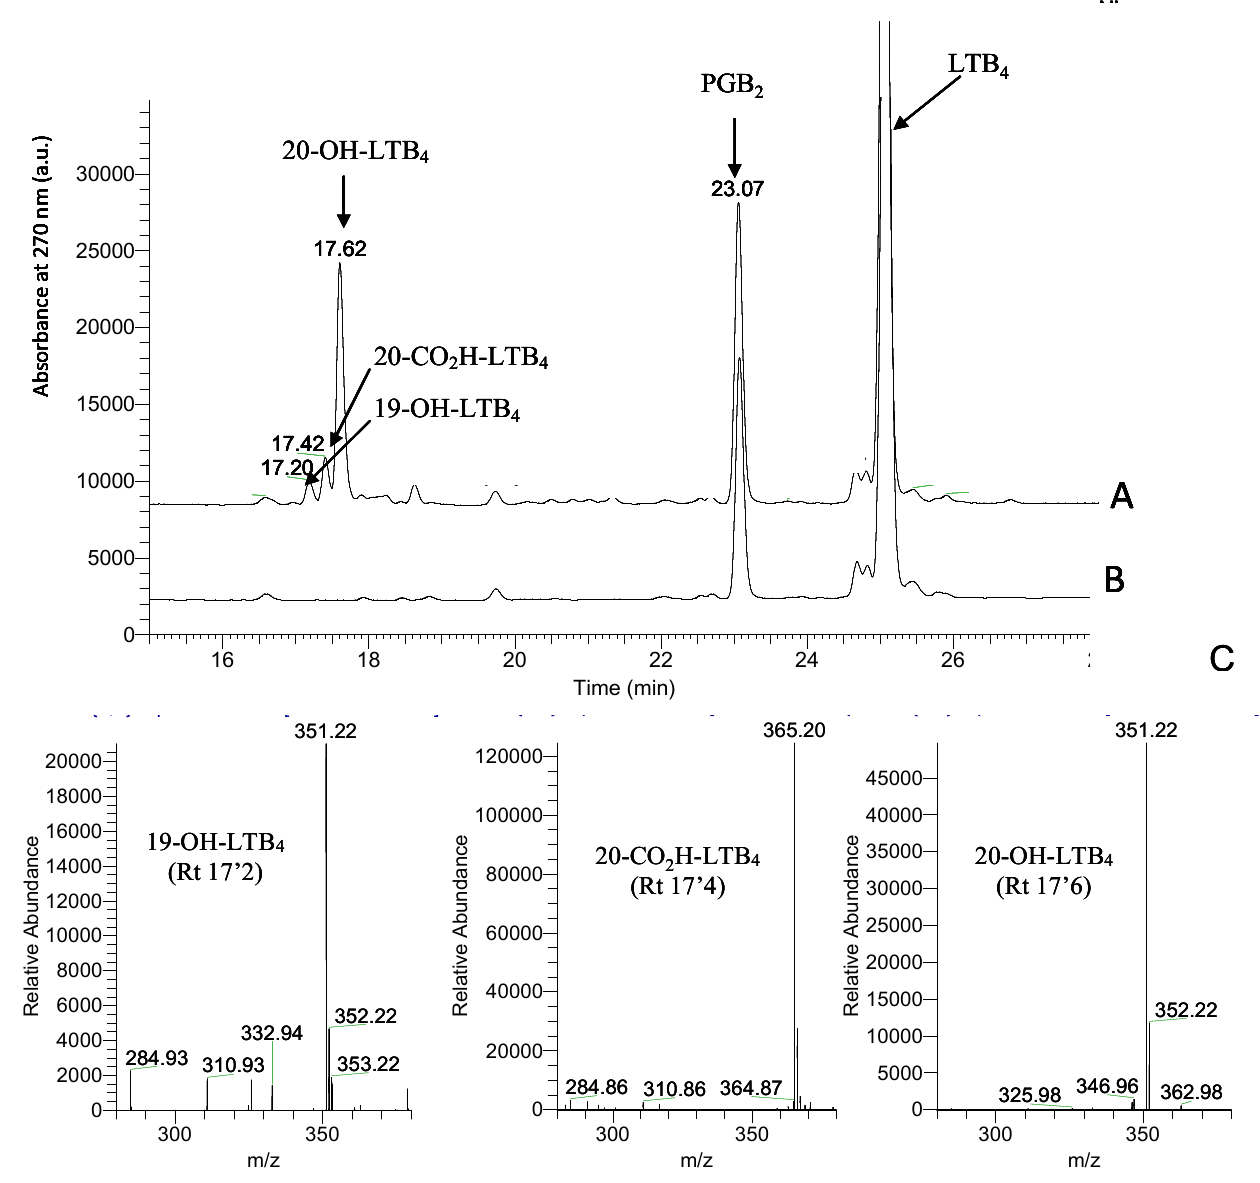
Figure 1. ( A ) Typical reverse-phase HPLC analysis of LTB 4 incubated for 15 min at 28 °C in the presence of microsomes from yeast transformed to express CYP2U1(incubation and analysis conditions in Materials and Methods). ( B ) Same incubation as in A but in the absence of NADPH. Figure shows the absorbance at 270 nm. ( C ) Mass spectra of the observed metabolites of LTB 4 absorbing at 270